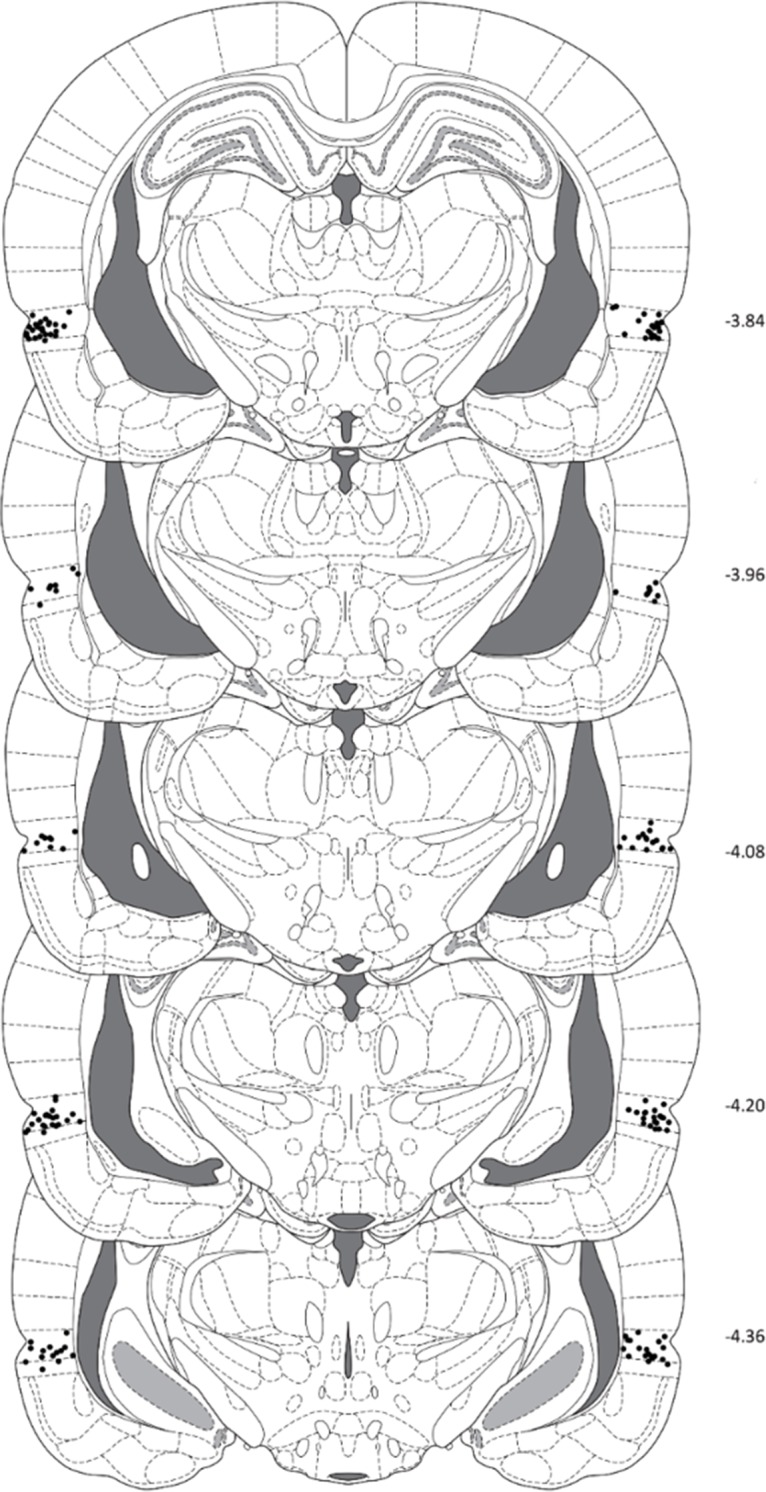
Cannula placements in the PRh taken from rats in Experiments 2–5.The most ventral portion of the cannulas are marked on coronal sections based on the atlas of Paxinos and Watson (2006).